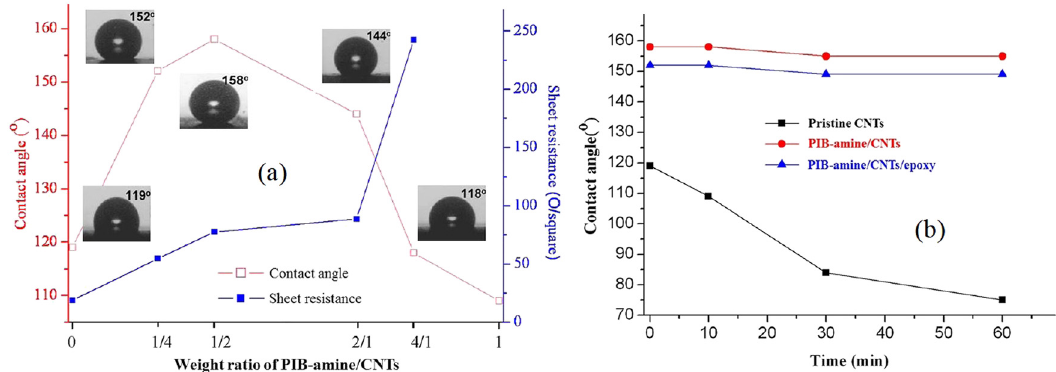
Figure 9: ( a ) Variation of sheet resistance and CA as a function of PB - amine/CNT weight ratio. ( b ) Time - dependent CA variation in water [ 152 ] . Reproduced with permission from ref. [ 152 ] ; © 2013 American Chemical Society.